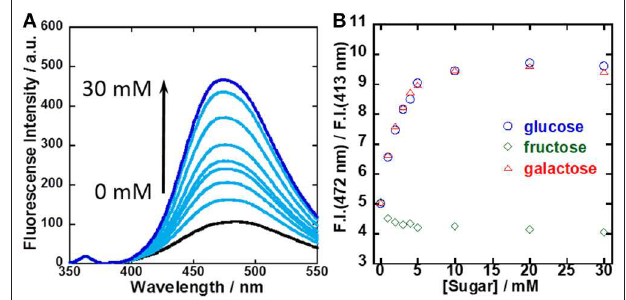
FIGURE 6 | (A) Fluorescence spectral changes of 1 / γ -CyD complex in 2% DMSO − 98% water (v/v) at pH 7.4 with the addition of glucose. (B) Ratiometric plots of 1 / γ -CyD complex in 2% DMSO − 98% water (v/v) at pH 7.4 with the addition of various concentrations of sugars. [ 1 ] = 10 µ M, [ γ -CyD] = 5mM, [sugar] = 0–30mM, [phosphate buffer] = 10mM, [NaCl] = 100mM, λ ex = 323nm.